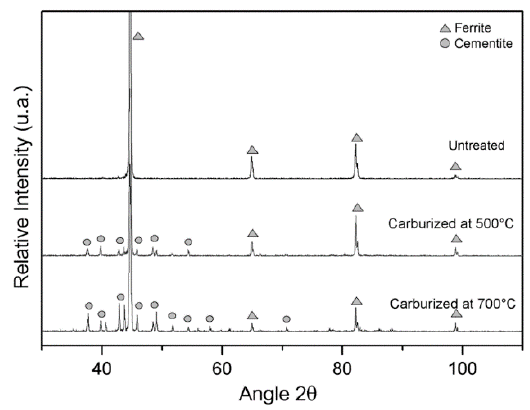
Figure 7. X-ray diffraction patterns for the samples carburized at 500 °C and 700 °C with 5% CH